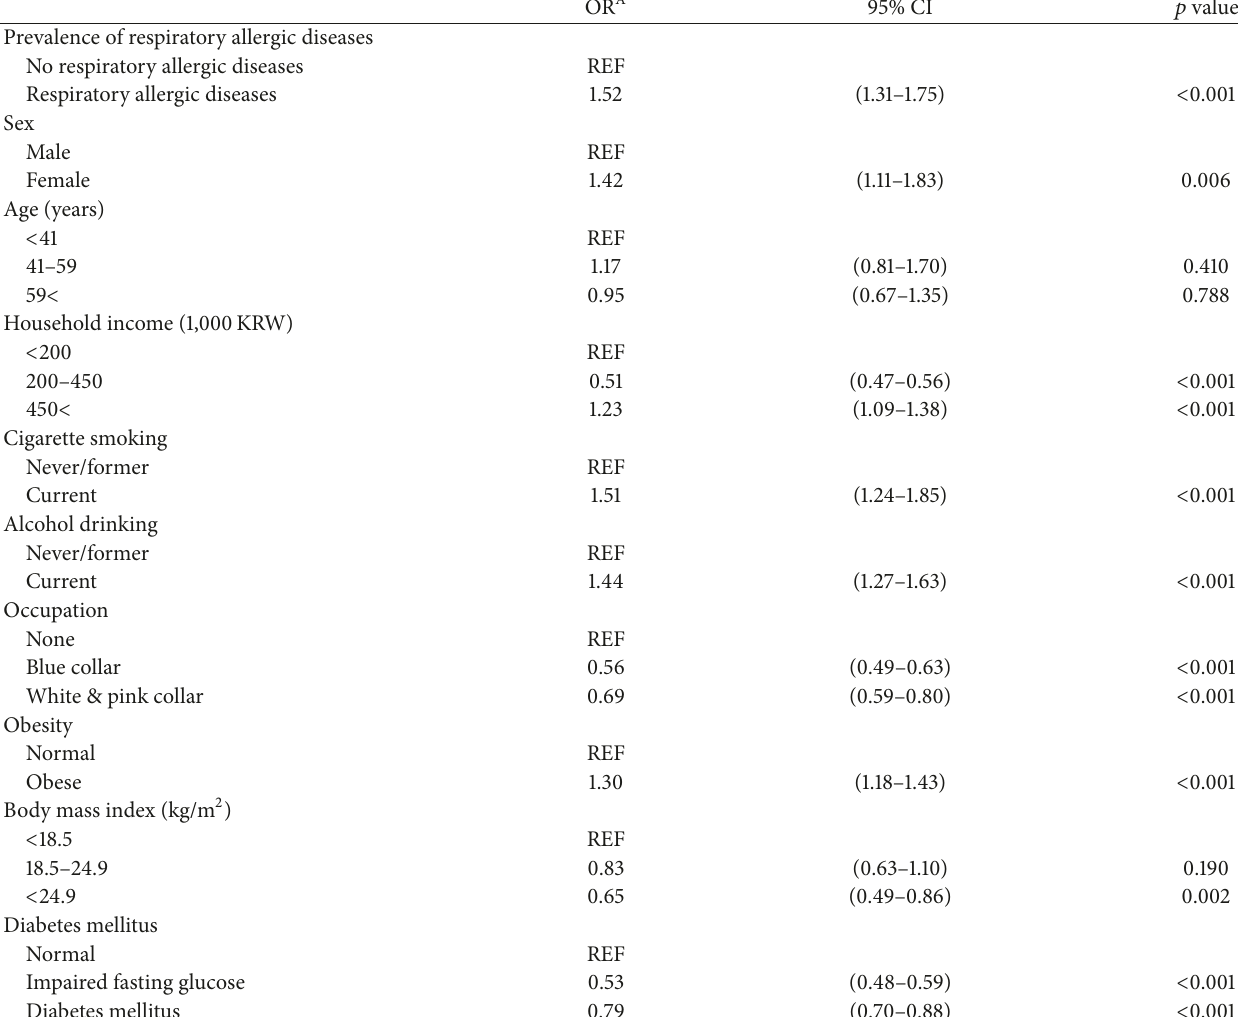
Table 2: Matched conditional logistic regression of prevalence of RA.